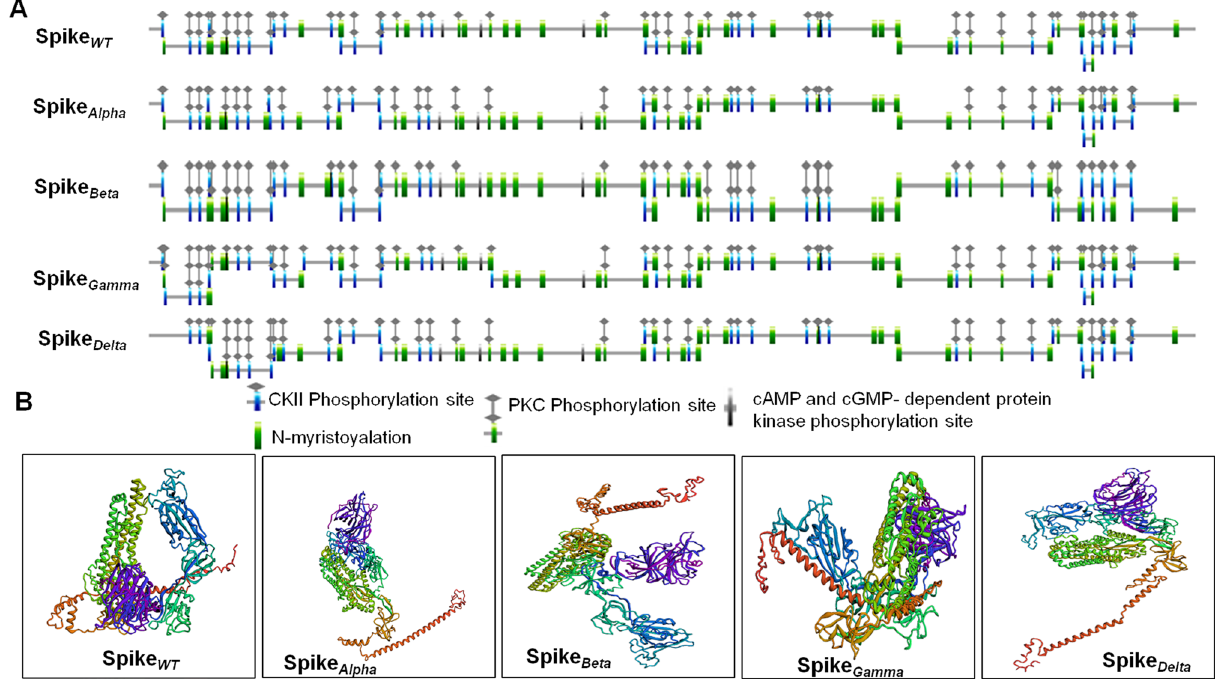
Figure 3. (A) Prediction of different post-translational sites in wild-type and mutant spike proteins. (B) Prediction of the tertiary structure of wild-type and mutant spike proteins using RoseTTAFold